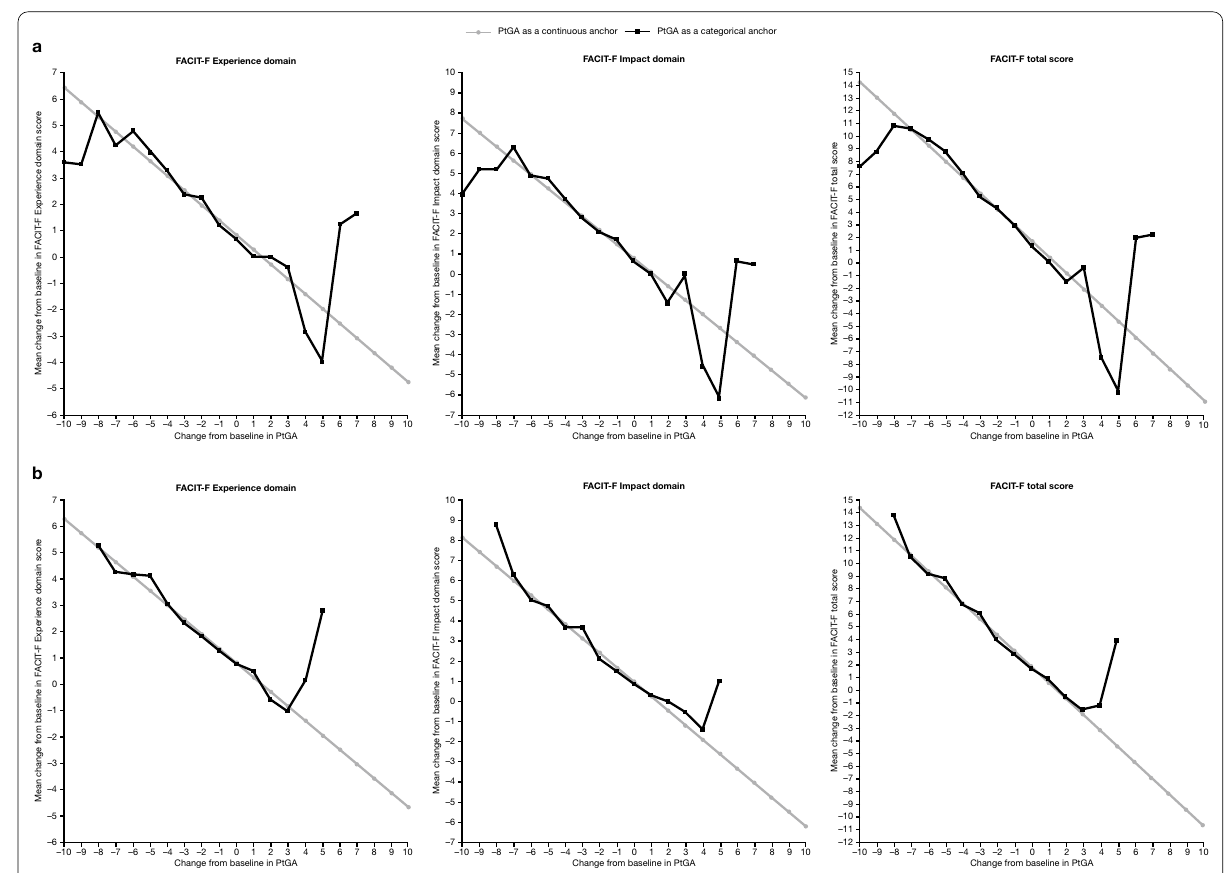
Fig. 1 Relationship between change from baseline in FACIT‑F Experience domain, Impact domain, and total scores, and change from baseline in PtGA scores in patients with active AS in a Study 1* and b Study 2 † . *NCT01786668 (phase 2 study). † NCT03502616 (phase 3 study). AS, ankylosing spondylitis; FACIT‑F, Functional Assessment of Chronic Illness Therapy‑Fatigue; PtGA, Patient Global Assessment